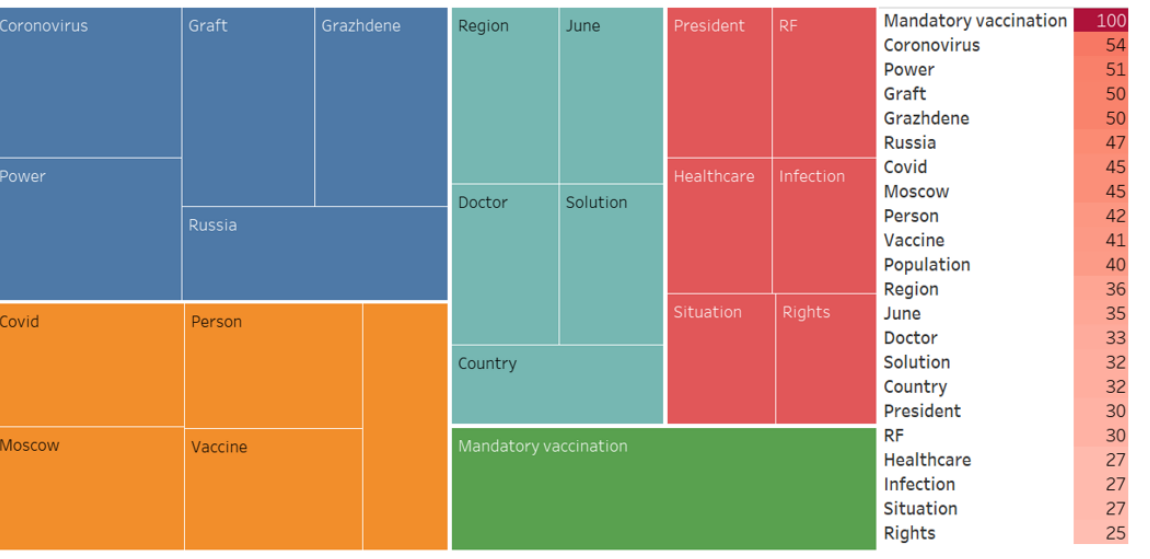
Figure 7. Associative network of the “Mandatory vaccination” stimulus in the negative cluster.